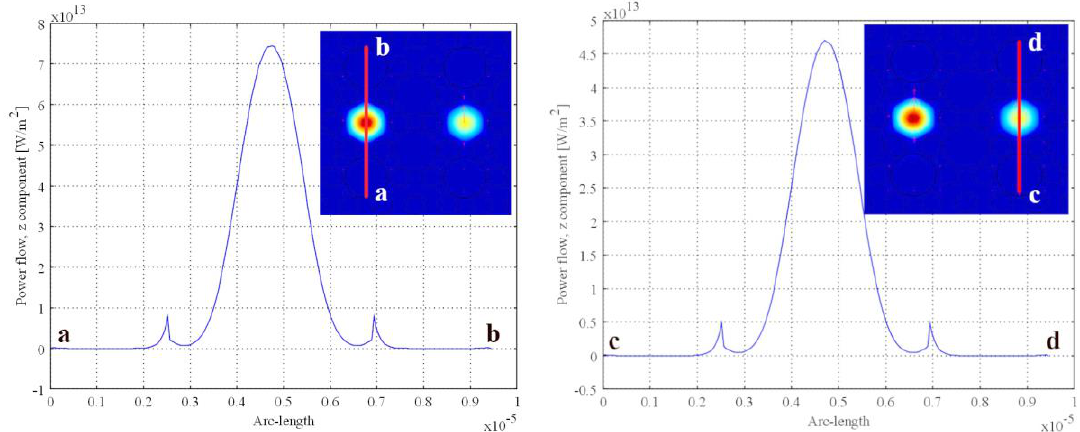
Figure 5. ( Left ): Power flow distribution along the red line from point a to point b with n = 1.40 at the phase matching point (a and b in the illustration are the head and terminal of the red line, respectively); ( Right ): Power flow distribution along the red line from point c to point d with n = 1.40 at the phase matching point. (c and d in the illustration are the head and terminal of the red line, respectively).